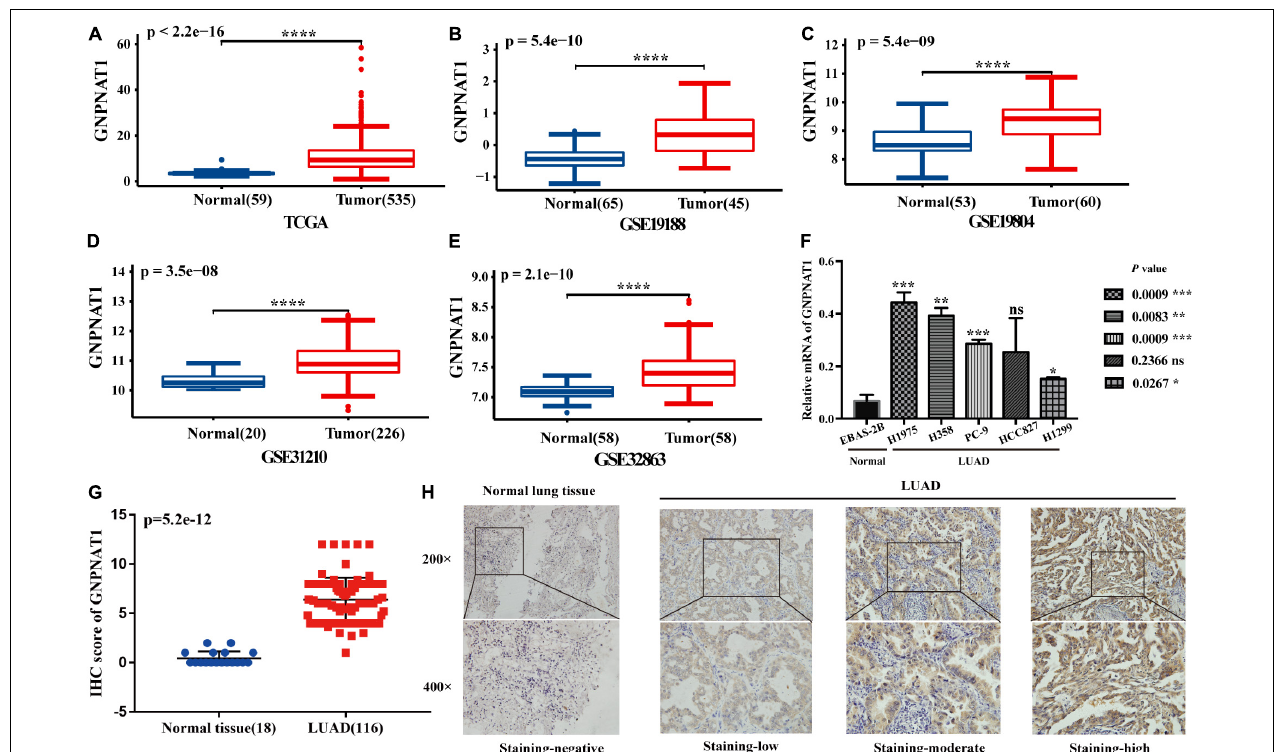
FIGURE 2 | The differential expression of GNPNAT1 in normal tissues and LUAD. (A) The differential expression of GNPNAT1 from the TCGA database. The differential expression of GNPNAT1 in GSE19188 (B) , GSE19804 (C) , GSE31210 (D) , and GSE32863 (E) . The expression level in different LUAD and normal lung cell lines (F) . The differential expression of GNPNAT1 from clinical samples (G) . The typical IHC staining results of GNPNAT1 in normal lung tissue and LUAD tissues (H) . * P < 0.05, ** P < 0.01, *** P < 0.001, and **** P < 0.0001, ns: insignificant.